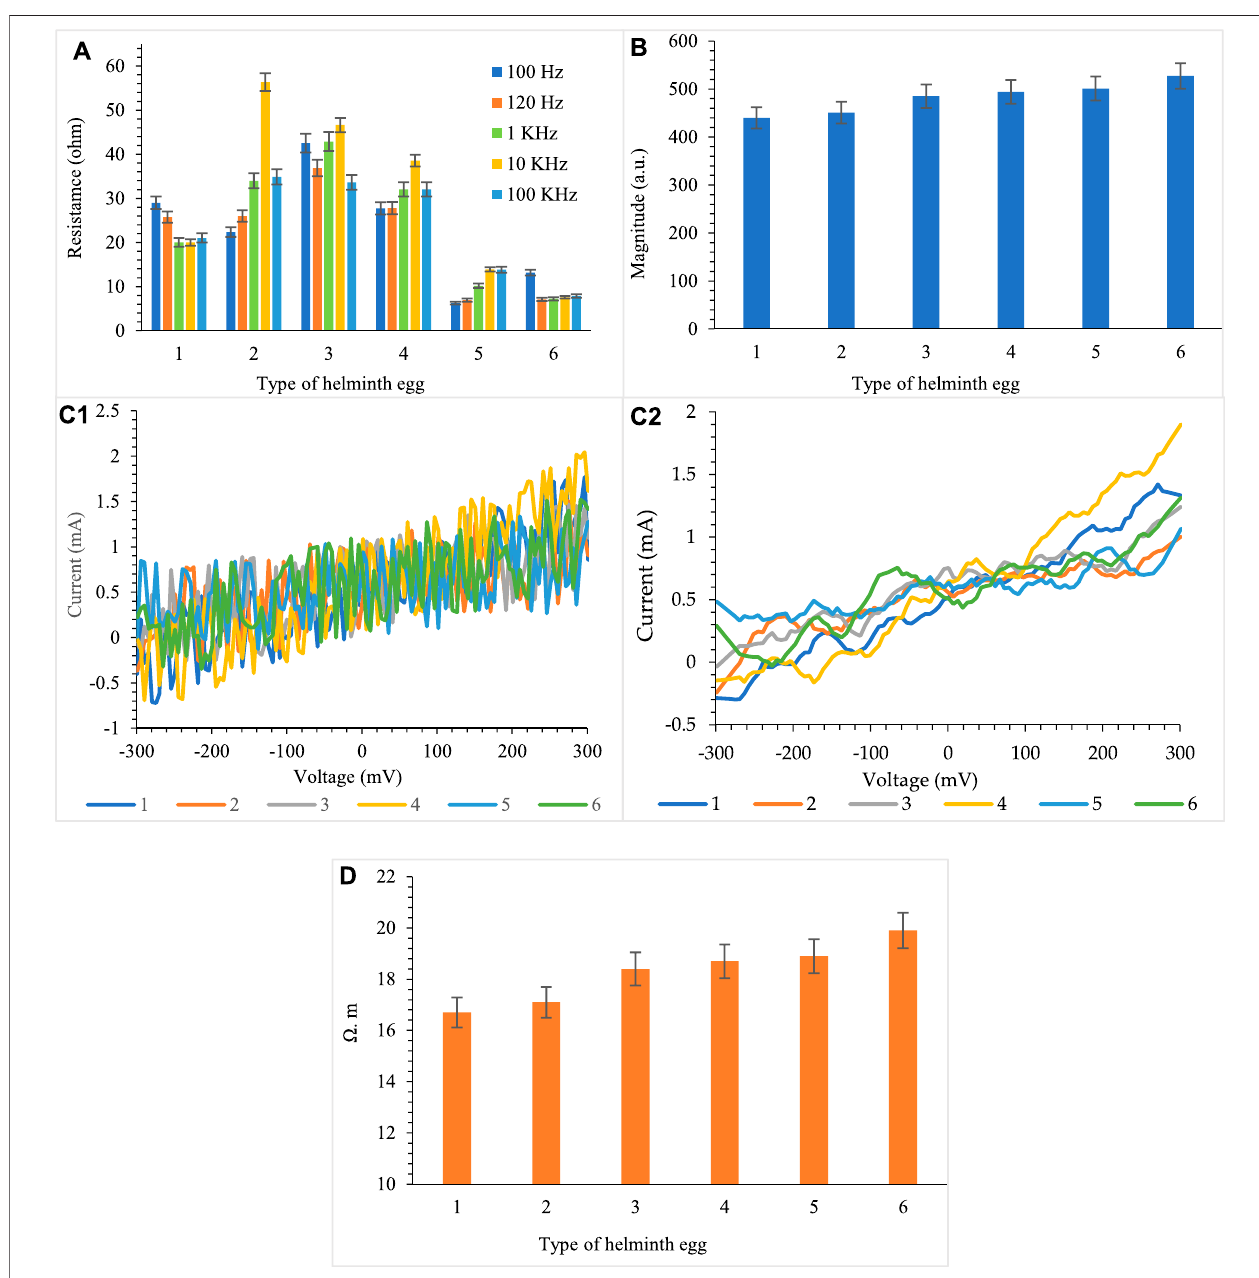
FIGURE 6 | The resistance determination by (A) LCR meter, (B) DC resistance, (C) non-smoothed and smoothed normal DC resistance of helminth eggs (c 1 , c 2 ), and the (D) resistivity measurement, for fi ve repetitions during implanting of three-microelectrodes with 0.0124 ± 0.0008 mm inter-electrode distance, error bar: ± standard deviation ( n (cid:2)